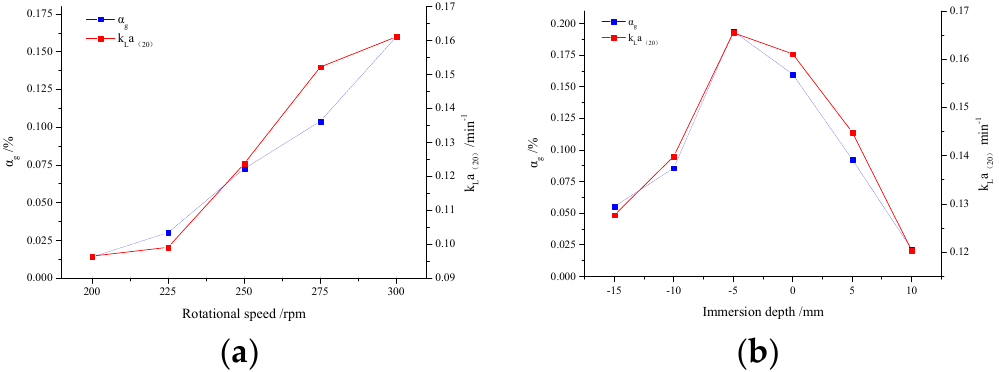
Figure 9. Variation of α g and k L a (20) . ( a ) Variation of α g and k L a (20) under different rotational speeds; ( b ) Variation of α g and k L a (20) under different immersion depths.